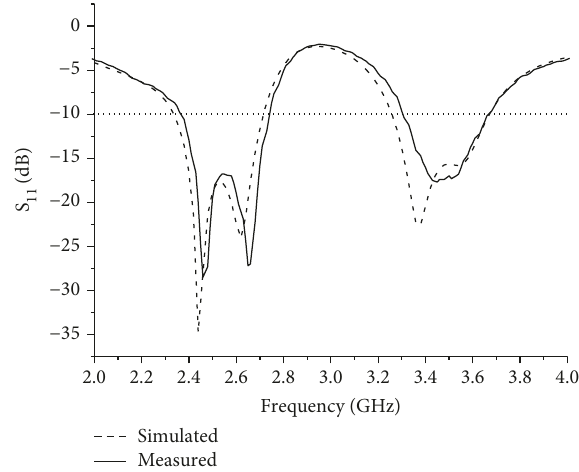
Figure 9: Simulated and measured S